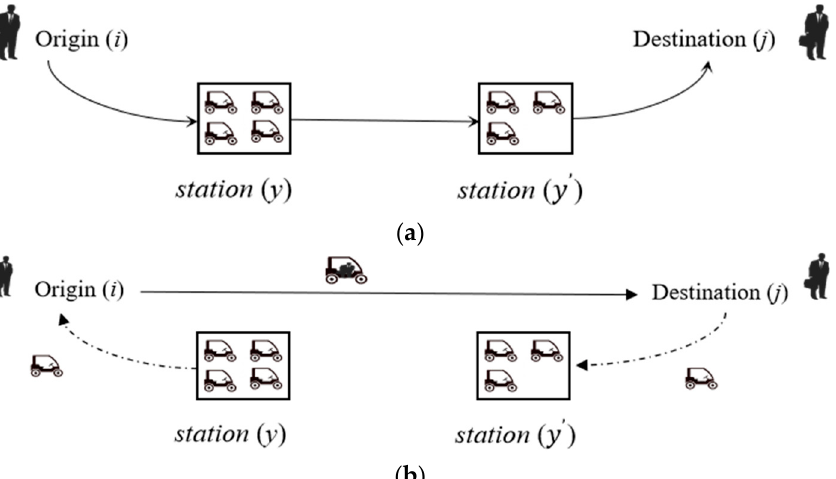
Figure 1. Service modes in hybrid carsharing systems: ( a ) Service mode of CSCs, and ( b ) Service mode of